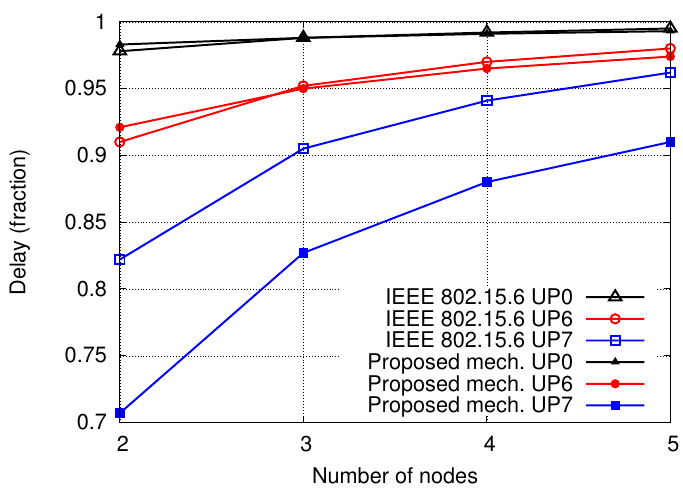
Figure 7. Delay comparison of IEEE 802.15.6 and proposed mechanism for different UP.